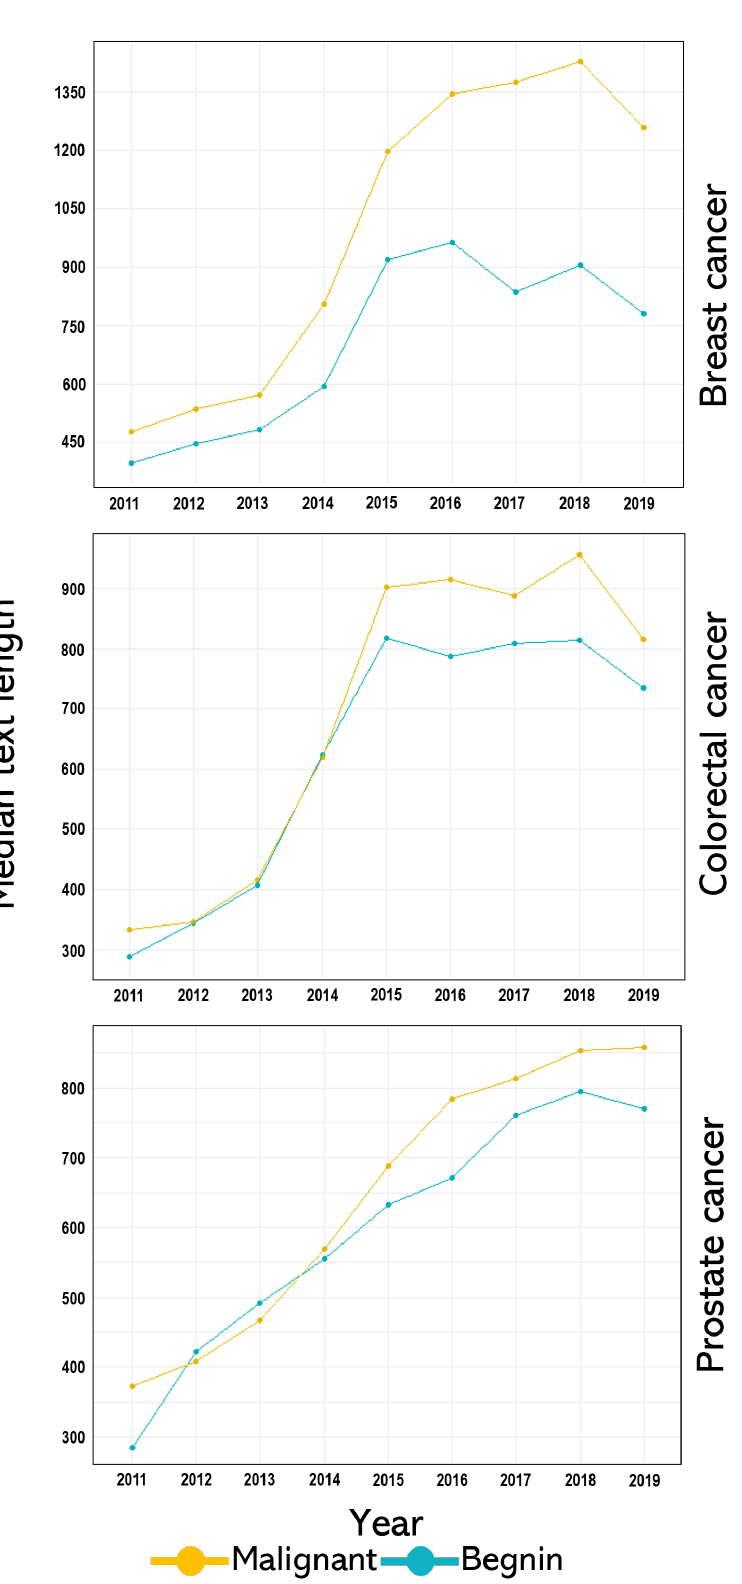
Figure 4. Distribution of median text length across the study period for each cancer diagnosis target class. The figures illustrate the increase in the median pathology reports over the years. Class imbalance is noticeable with the breast cancer reports across the years when compared to prostate and colorectal